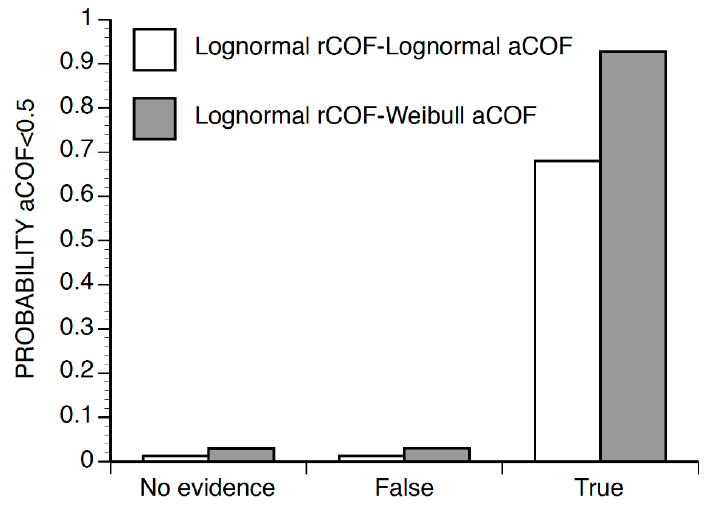
Figure 4. Probability of the ACOF being less than 0.5 when three difference levels of evidence (no evidence, true, and false) were entered at the slip